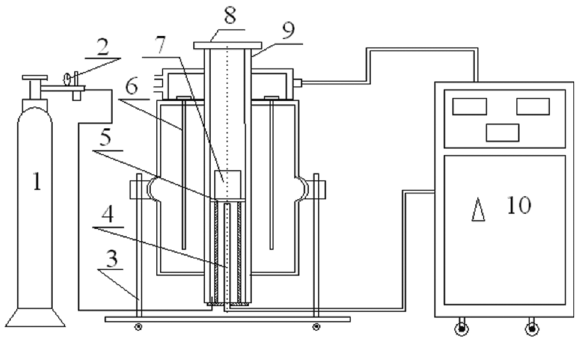
Figure 2: Experimental apparatus of heating